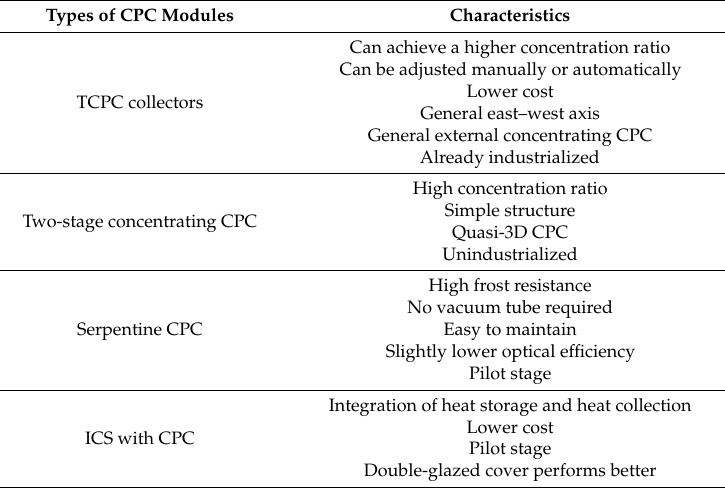
Table 6. Comparison of di ff erent tubular absorber CPC